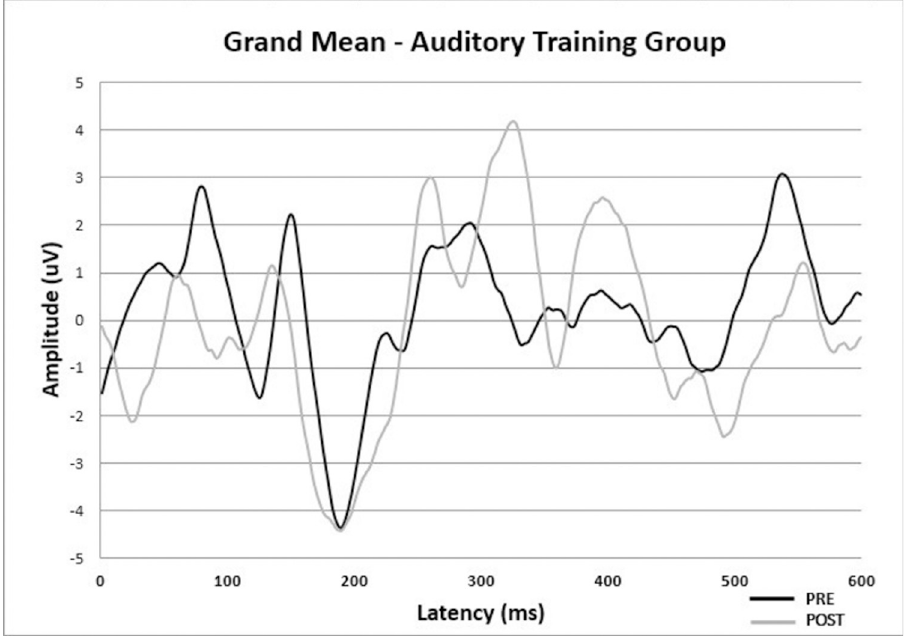
Fig 1. Cortical auditory evoked potential responses grand average at pre-and post-assessment of auditory training